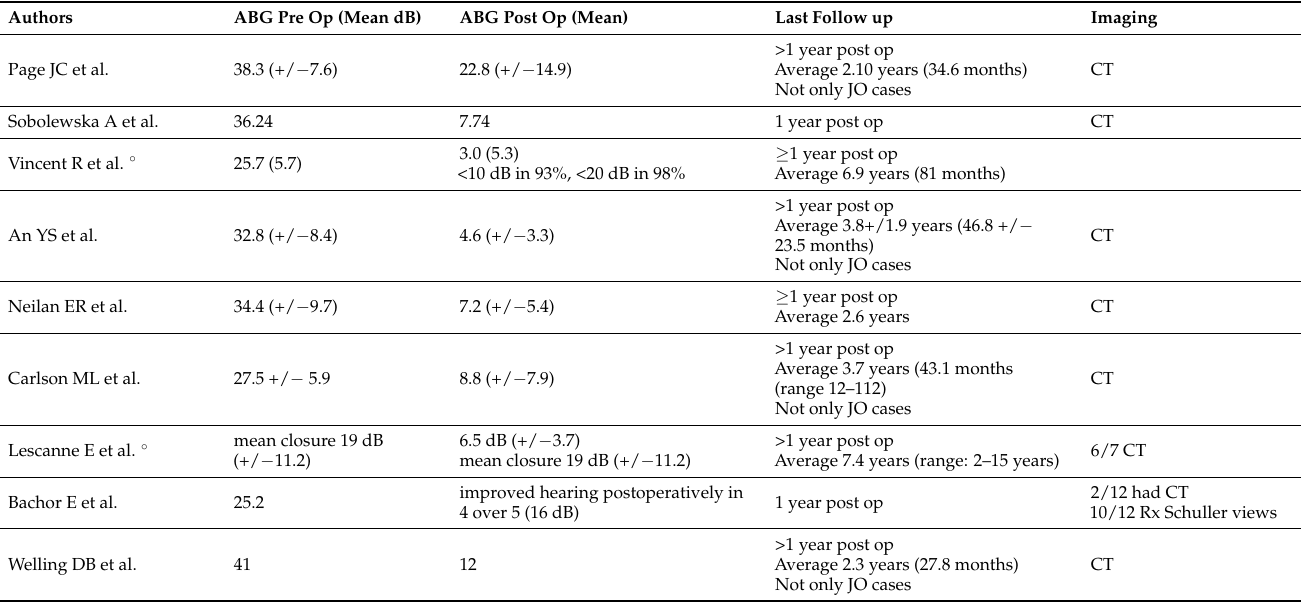
Table 3. Hearing assessment and investigations. CT= Computed Tomography; BCHL = bilateral conductive hearing loss; ◦ = studies focused only on